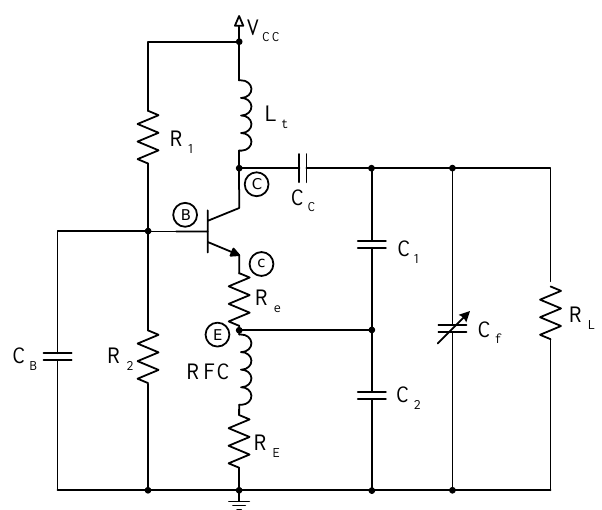
Figure 2. General scheme of the Colpitts